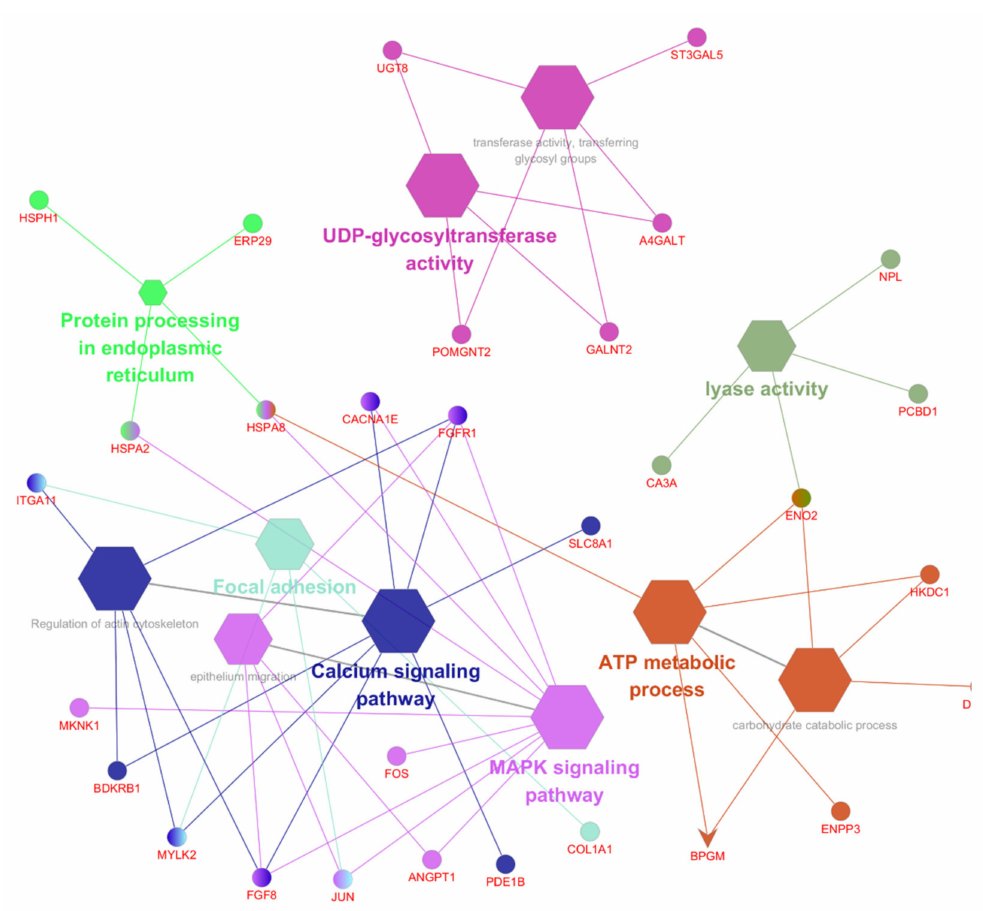
Figure 6. Gene network of the top 10 KEGG pathways with the elliptical shape representing the upregulated genes and the V shape representing the downregulated genes,